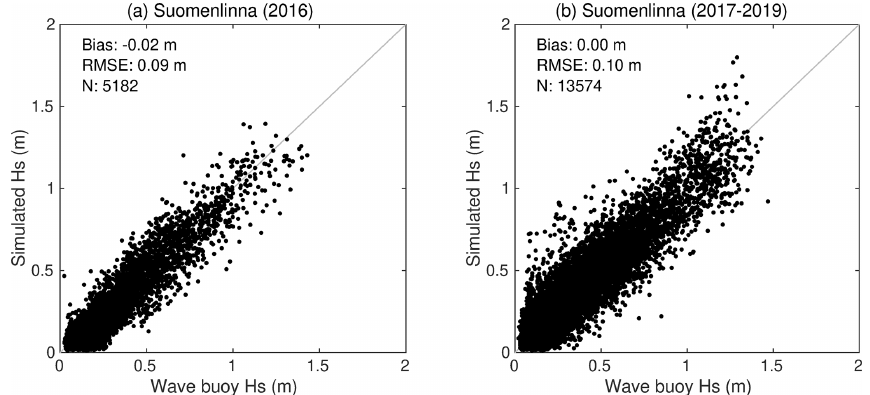
Figure 2. The significant wave height simulated by the parametric wave model compared with observations from the Suomenlinna wave buoys. The (a) 2016 data used for model calibration and (b) the 2017–2019 data are shown